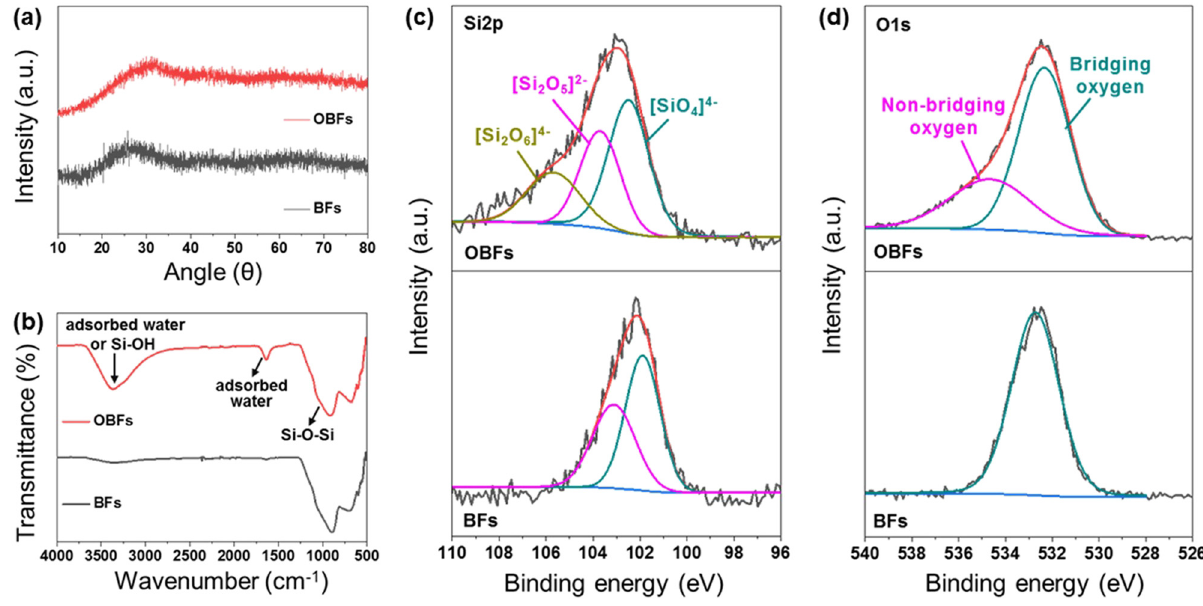
Figure 2: Characterization of BFs and OBFs: ( a ) XRD, ( b ) FT - IR spectra, ( c ) Si2p core level of XPS spectra, and ( d ) O1s core level of XPS